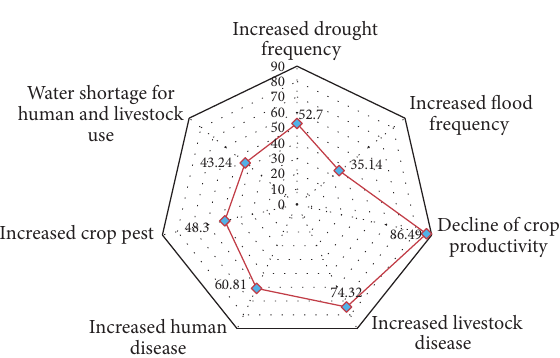
Table 3: Trends of changes in the annual minimum and maximum temperatures of weather stations in Southwest Ethiopia.